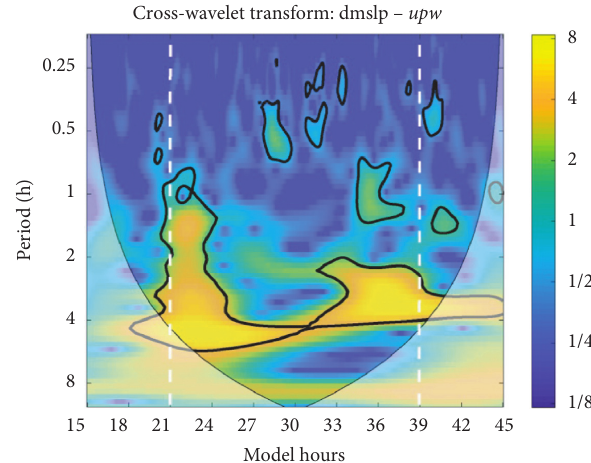
Figure 8: Power spectrum of the cross-wavelet transform of the standardized Δ MSLP and eyewall averaged updraft at 200hPa (equation (1)). The 90% significance level against red noise is shown as a thick contour, and the cone of influence, where edge effects might distort the picture, is shown as a lighter shade. The analyzed period is between the two white dotted